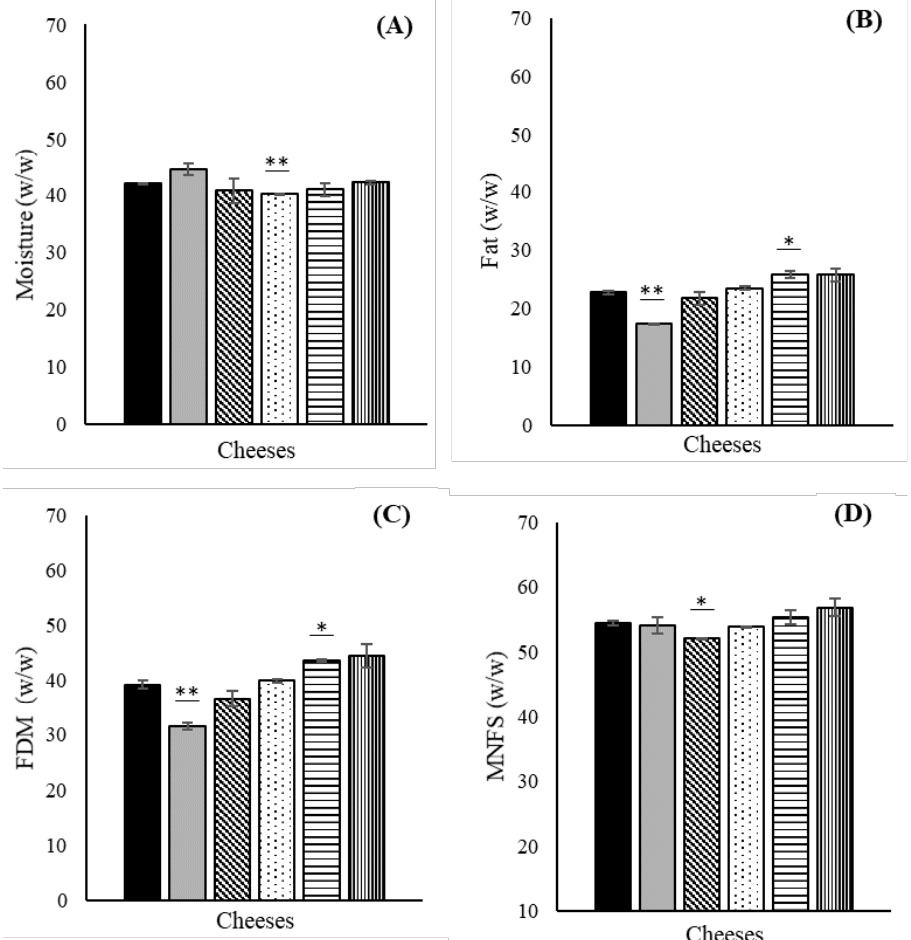
Figure 1. Physicochemical composition in percent of the experimental costeño-type cheese: ( A ) Moisture; ( B ) Fat; ( C ) Fat-in-dry-matter (FDM); ( D ) Moisture-in-non-fat-substances (MNFS) in Q C (black bar), Q 1 (gray bar), Q 2 (diagonal striped bar), Q 3 (point bar), Q 4 (horizontal striped bar) and Q 5 (vertical striped bar). Error bars represent one standard deviation. Student’s t -tests were performed to assess significance compared to the control cheese (Q C ), where (*) corresponds to a p -value < 0.05, and (**) to a p -value < 0,01.